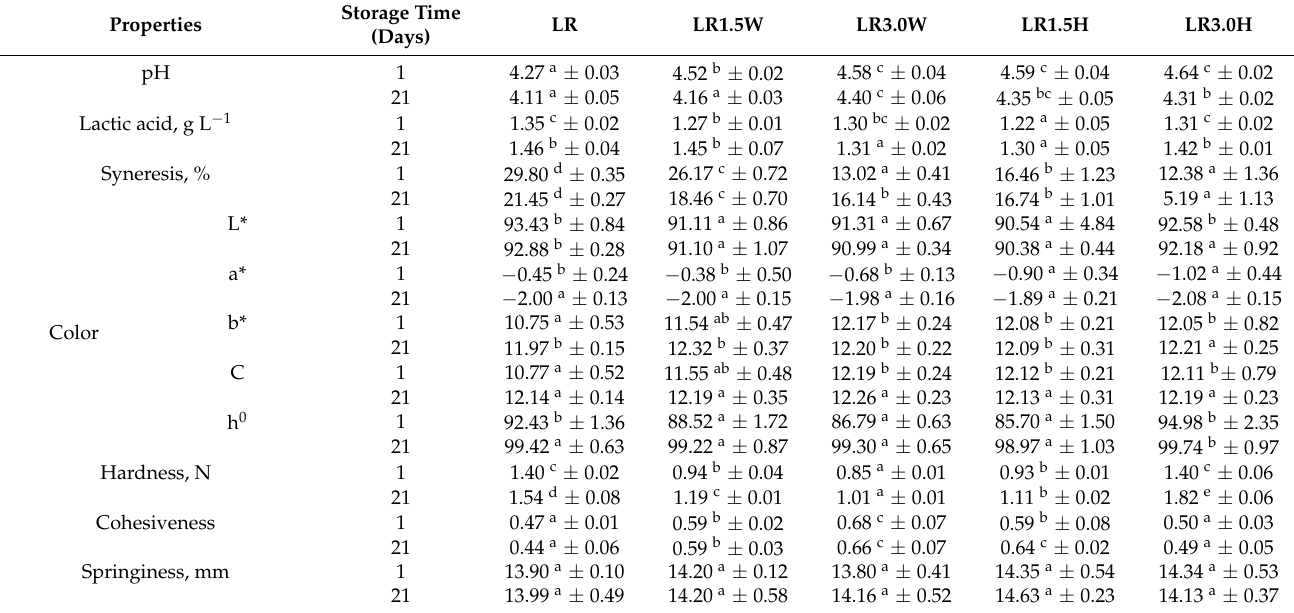
Table 4. Acidity, syneresis, color and texture of sheep’s milk fermented by Lacticaseibacillus rhamnosus